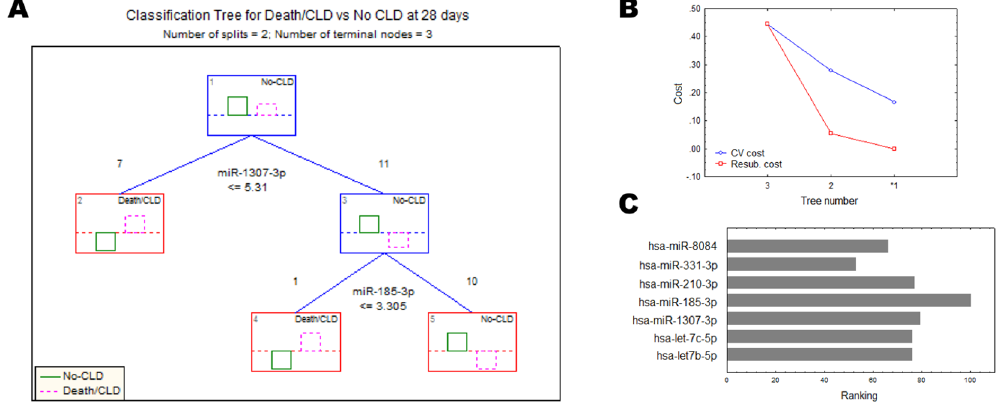
Figure 4. Classification of cases was used to obtain the relative importance of differentially expressed circulating miRNAs for the Death/CLD condition outcome. The corresponding chosen classification tree (A) , the costs of the cross-validation procedure (B) and the predictor importance ranking (C) for the chosen tree (number 1, * ) are